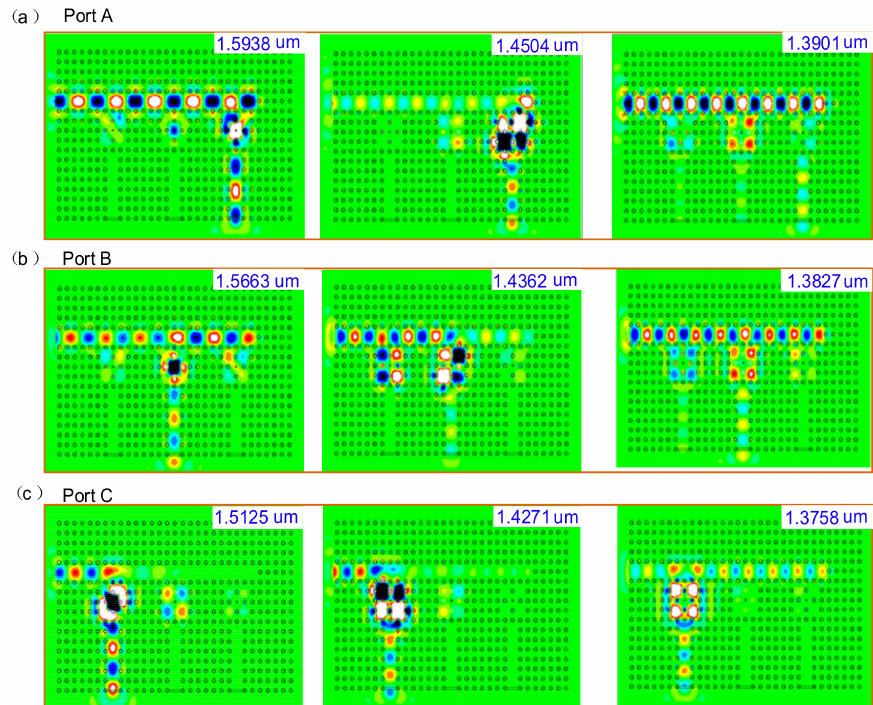
Figure 5. Distribution of Ey at different wavelengths.